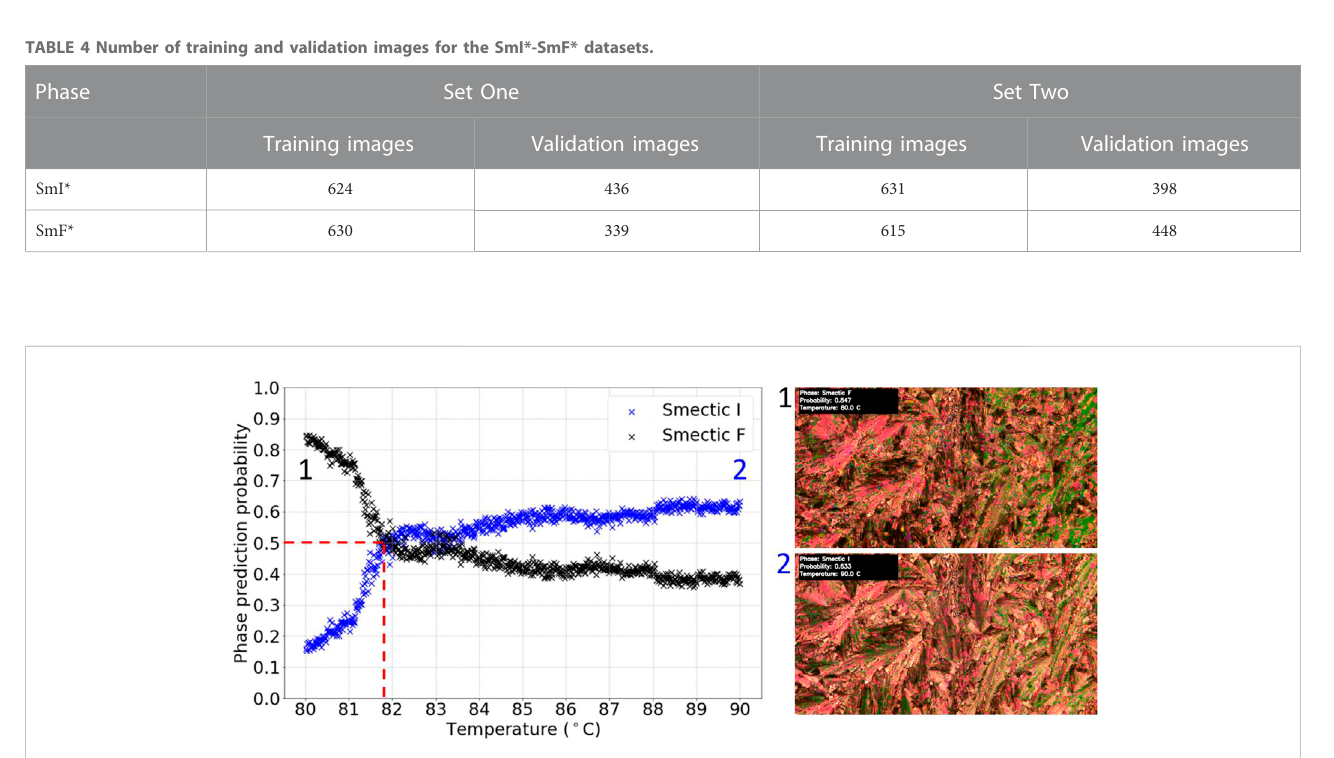
FIGURE 11 Graph of phase prediction probability against temperature for a labelled SmI*-SmF* transition test video. The vertical dashed line shows the identi fi ed transition